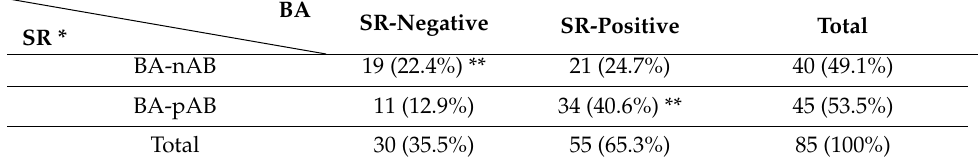
Table 1. Subjects’ distribution according to SR and BA groups.